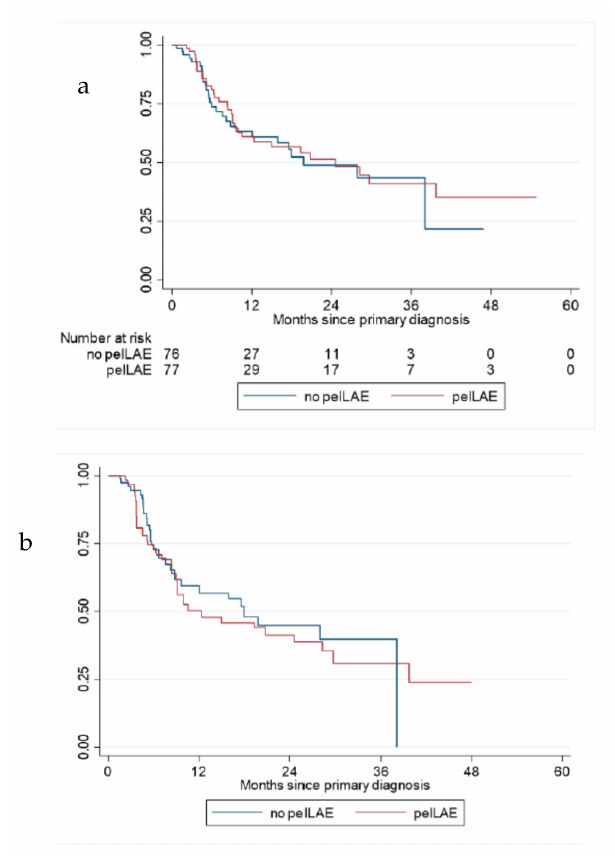
Figure 1. Kaplan–Meier curve for disease-free survival (DFS); local recurrences excluded, ≥ pN2b ( a ) before IPTW and ( b ) after IPTW (inverse probability of treatment weighting). pelvLAE = pelvic